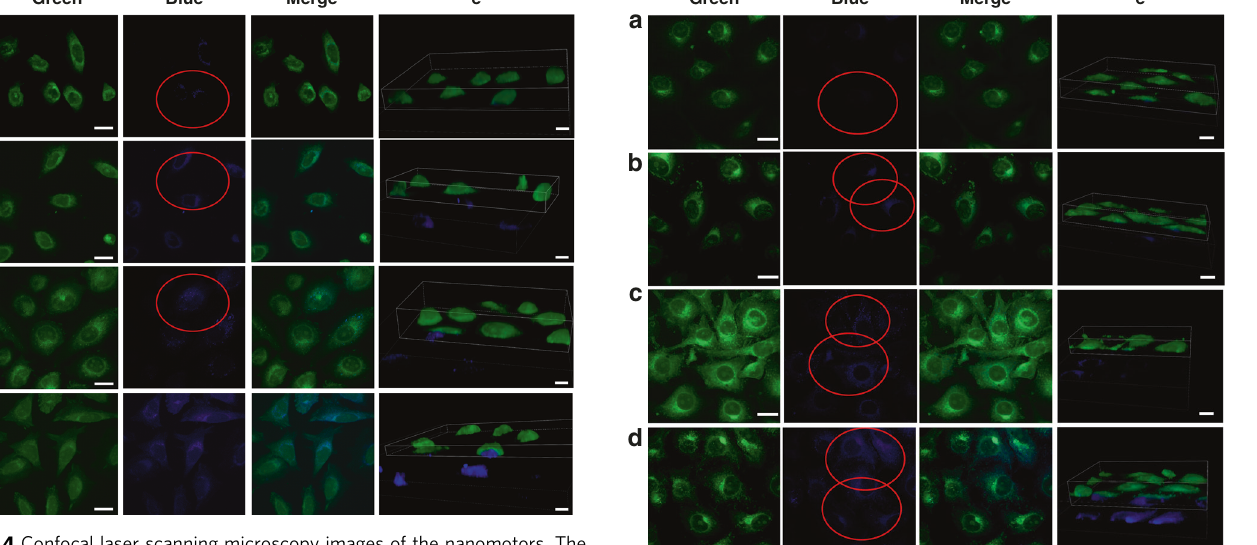
Fig. 4 Confocal laser scanning microscopy images of the nanomotors. The cellular uptake of HLA 10 nanomotor by MCF-7 under different conditions: a MCF-7 + HLA 10 nanomotor, b MCF-7 + 0.002% H 2 O 2 + HLA 10 nanomotor, c MCF-7 + NOS + HLA 10 nanomotor, d MCF-7 + NOS + 0.002% H 2 O 2 + HLA 10 nanomotor, and e a snapshot of a 3D rendered Movie nanomotors; Green: cell membrane) (Scale bar: 20 μ m)